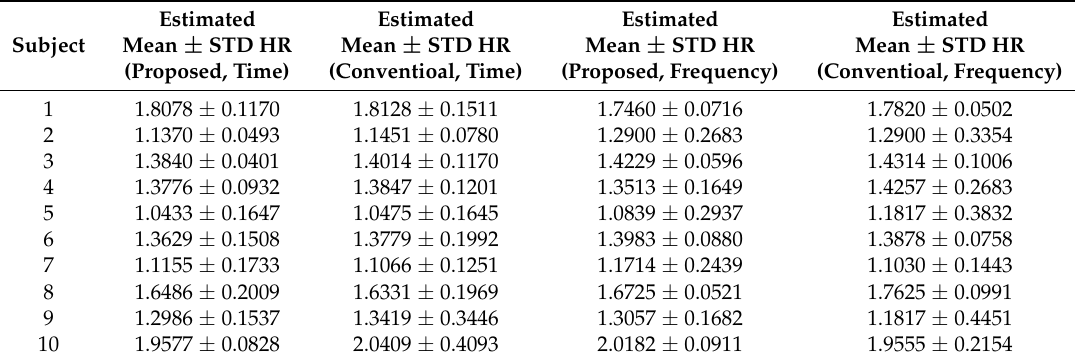
Figure 11. An example of the heart rate estimation of the proposed fingertip curve line movement-based and the conventional heart rate detection methods (frequency-domain estimation). Table 1. Mean and standard deviation (STD) heart rate (HR) of ten healthy subjects estimated by the proposed and conventional methods.